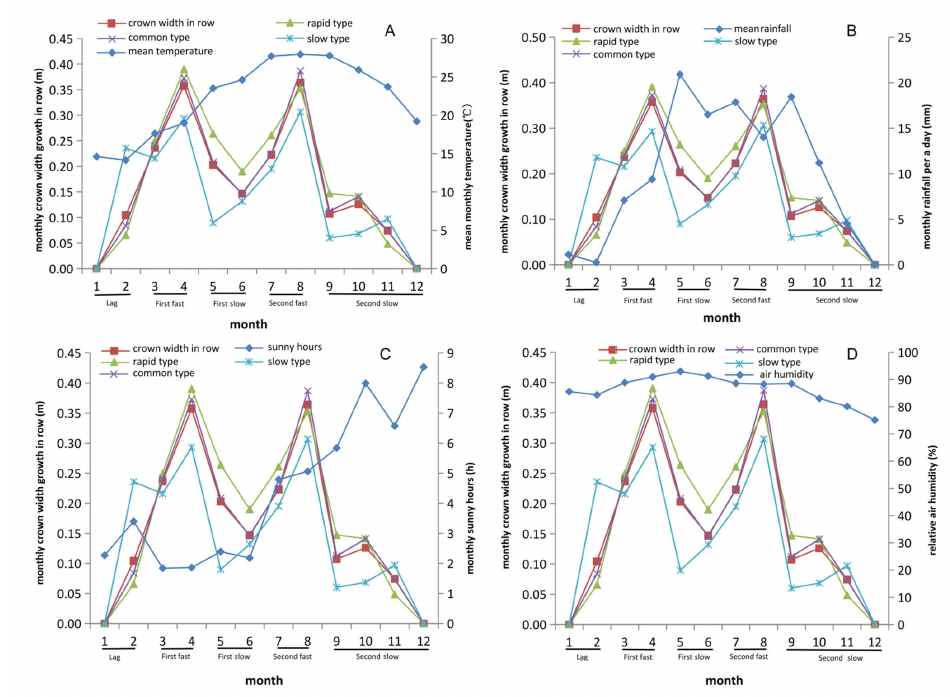
Figure 5. Dynamics of monthly crown width in rows and meteorological factors including tem- perature ( A ); rainfall ( B ); sunshine hours ( C ); and relative humidity ( D ). Meteorological data were supplied by Gaoming Meteorological Bureau, Foshan City, Guangdong Province, China.